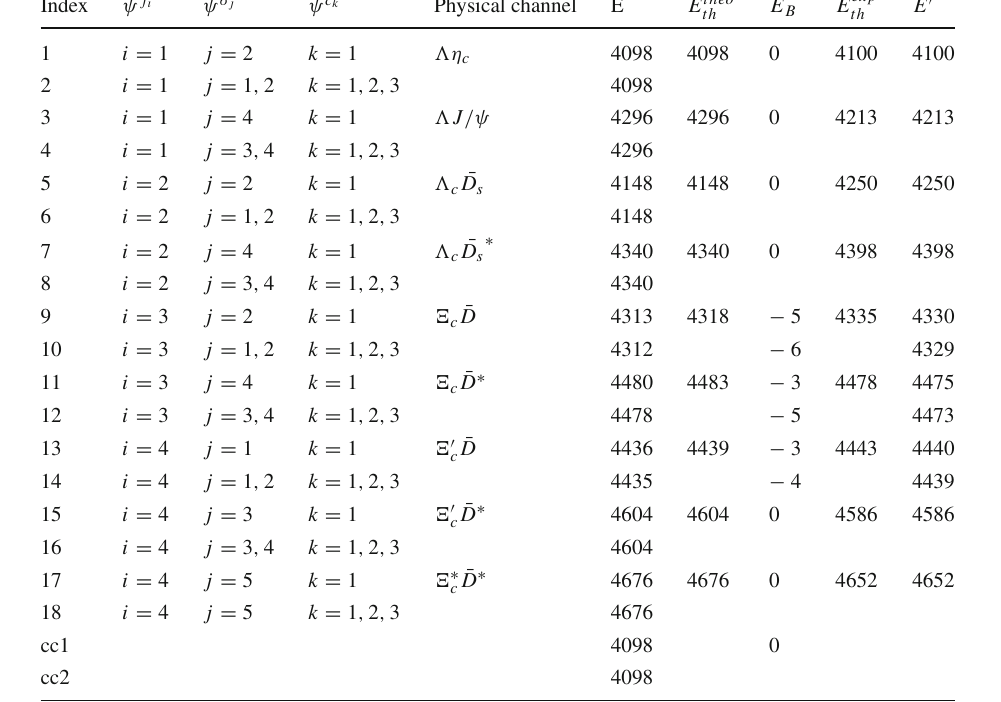
Table 4 The results for I J P = 0 3